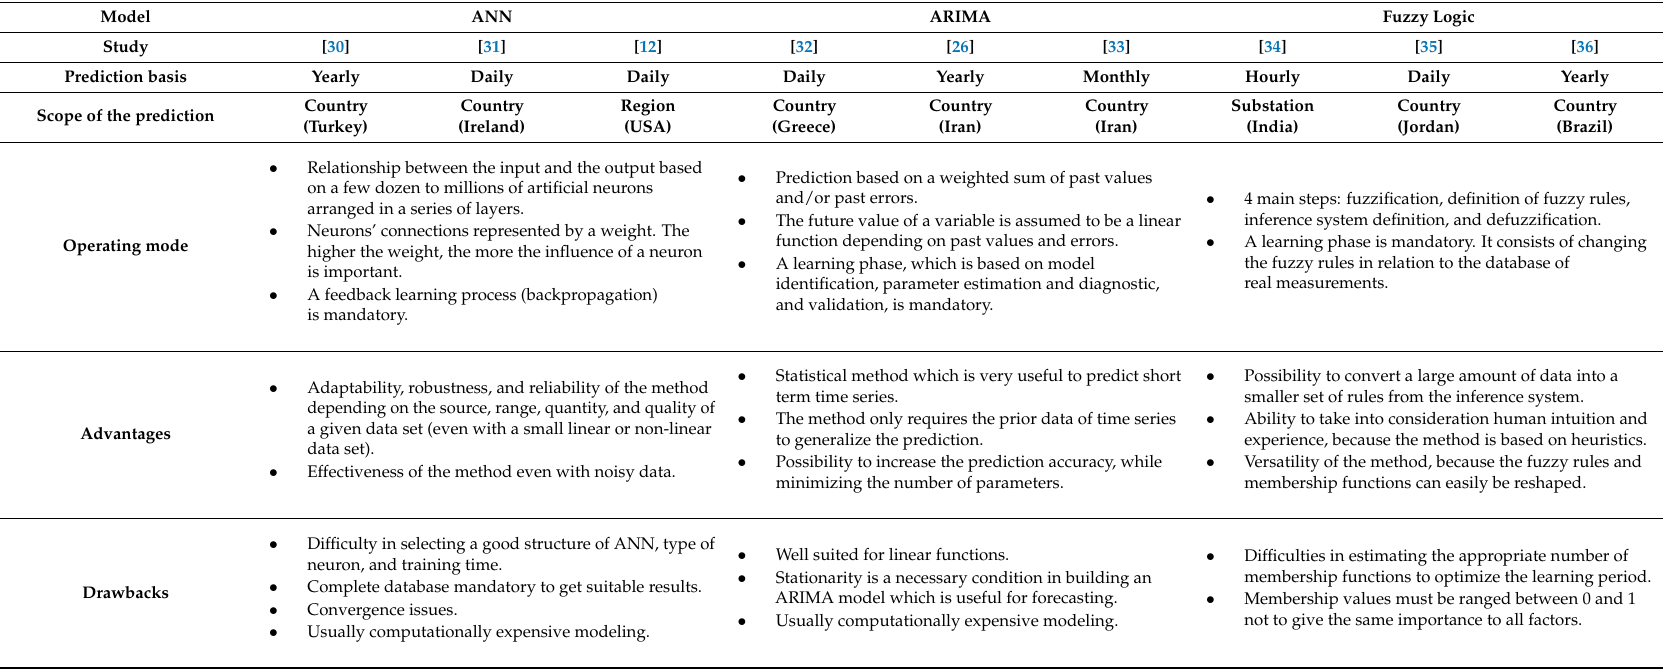
Table 3. Relevance of the fuzzy logic method in comparison with the ANN and ARIMA mathematical